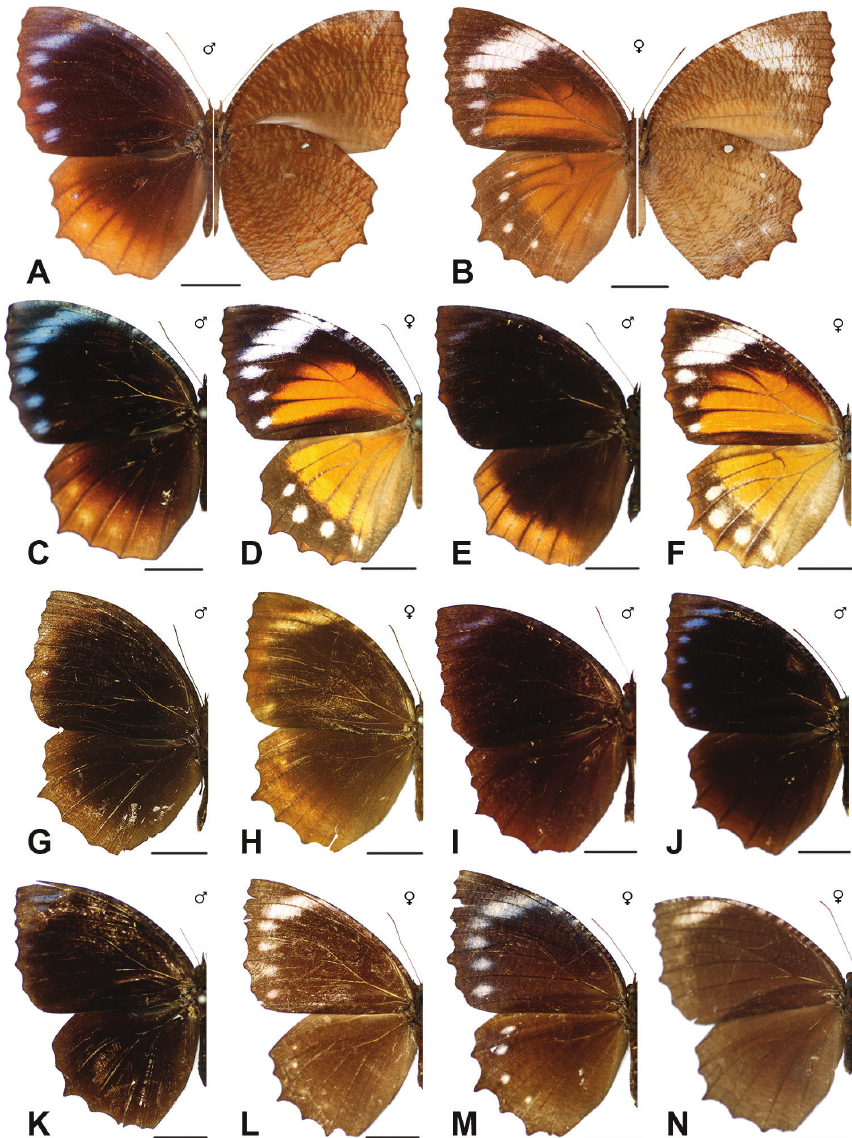
Figure 5. A hypermnestra hypermnestra ♂ D+V NHM Indonesia: Java, Bogor B hypermnestra hyperm- nestra ♀ D+V NHM Indonesia: Java, Bogor C hypermnestra undularis ♂ D NHM India: Assam D hy- permnestra undularis ♀ D NHM India: Sikkim E hypermnestra fraterna ♂ D NHM Sri Lanka F hy- permnestra fraterna ♀ D NHM Sri Lanka G hypermnestra cottonis ♂ D NHM India: Andaman Islands H hypermnestra cottonis ♀ D NHM India: Andaman Islands I hypermnestra nigrescens ♂ D NHM Bru- nei: Tutong J hypermnestra nigrescens ♂ D NHM East Malaysia: Sarawak, Mt. Marapok K hypermnestra nigrescens ♂ D NHM East Malaysia: Labuan; Holotype of Elymnias hecate L hypermnestra nigrescens ♀ D NHM East Malaysia: Sarawak, Mt. Mulu M hypermnestra nigrescens “f. pseudagina” ♀ D NHM East Malaysia: Sarawak N hypermnestra nigrescens ♀ D NHM Indonesia: Riau